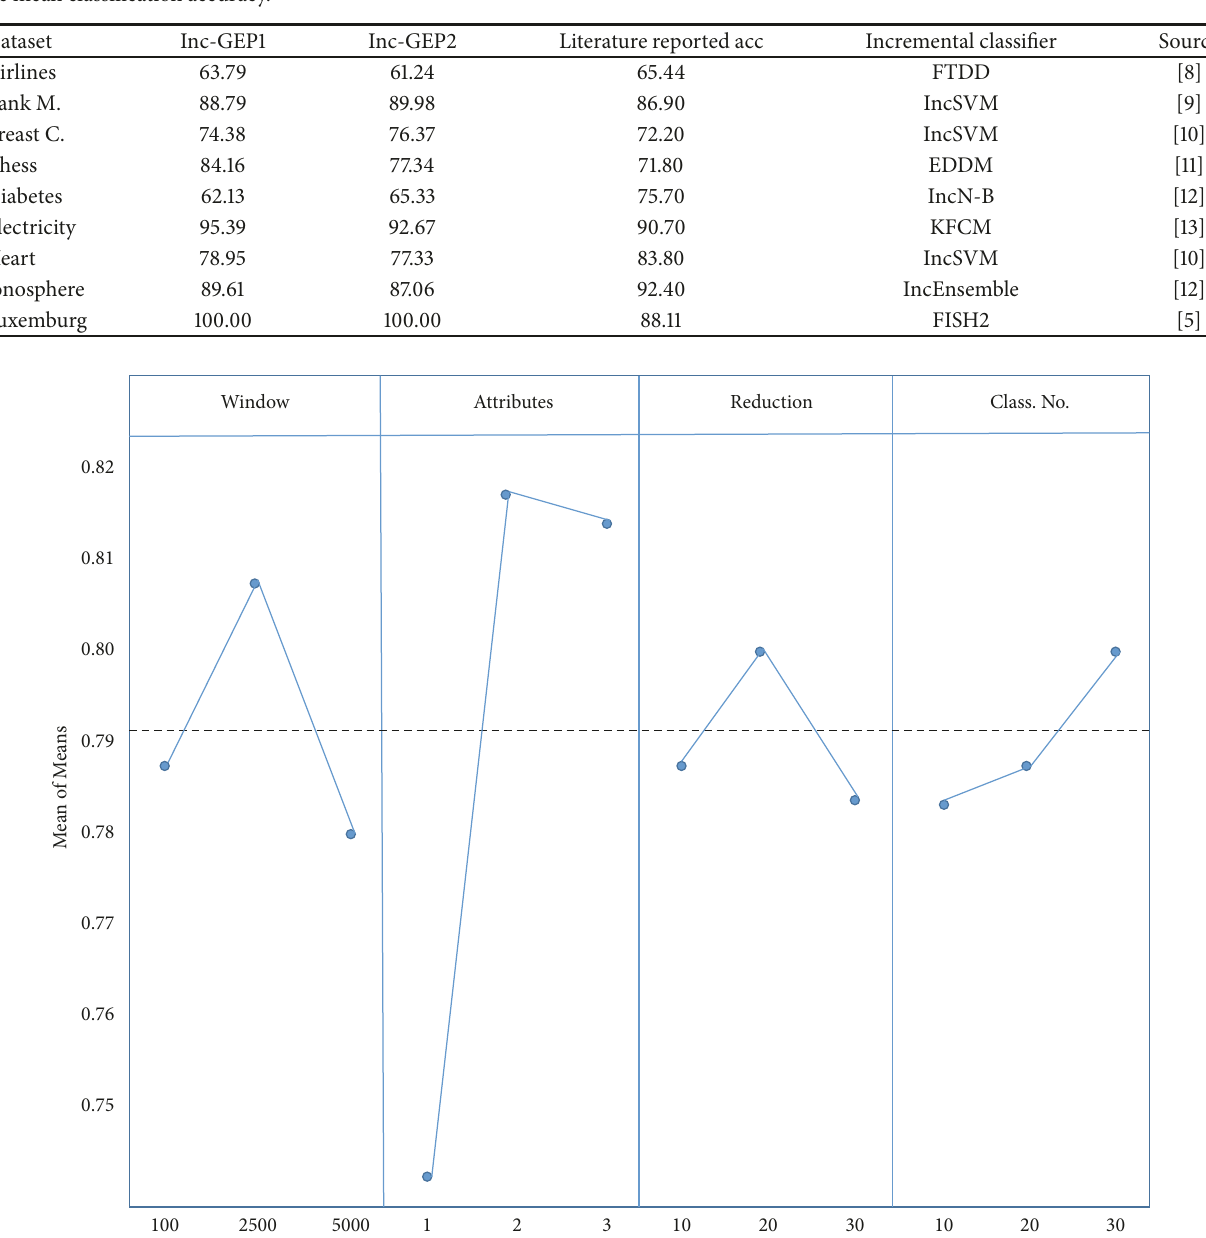
Figure 4: Main effects plot for classification time means: Sea